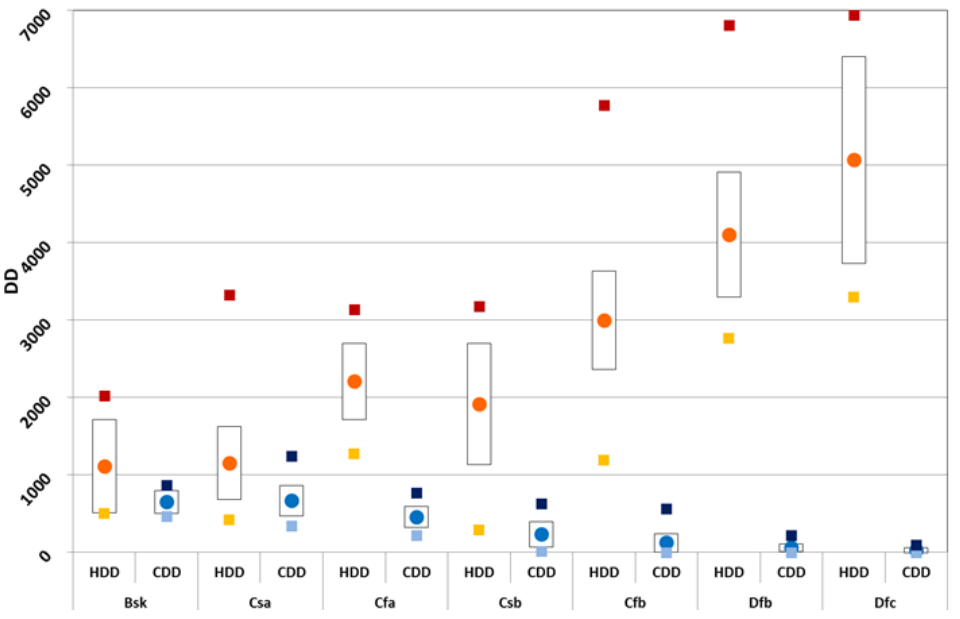
Figure 6. Average values (circles), standard deviation (bars), minimum and maximum values (squares) for the HDD (red, yellow and orange) and for the CDD (blue, light and dark blue) for the considered Köppen-Geiger classes in Europe.